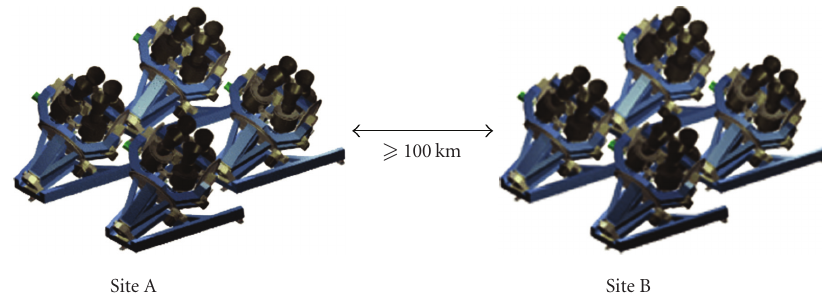
Figure 1: Schematic view of the final “Pi of the Sky”